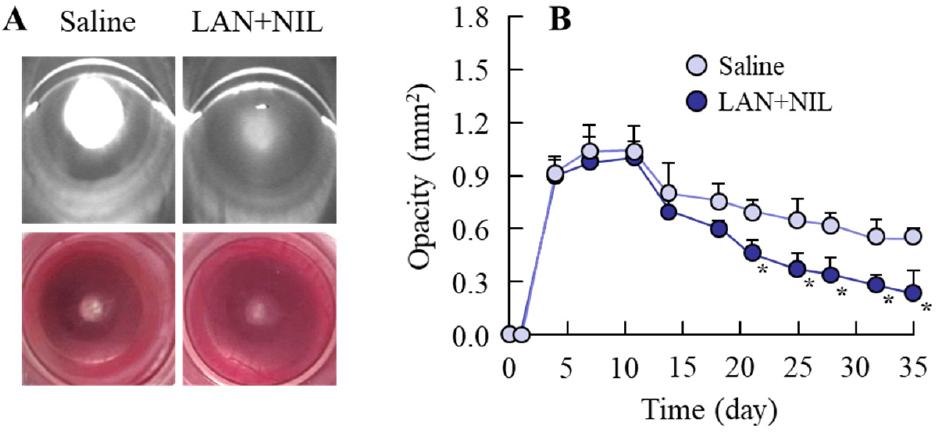
Figure 5. Effect of the combination of LAN-ONSs and NIL-ONSs on opacification in sodium-selenite- induced cataractic rats. ( A ): digital and Scheimpflug slit images of the sodium-selenite-induced cataractic rats repeatedly co-instilled with LAN-ONSs and NIL-ONSs. The images were measured at 35 days after the injection of sodium selenite. ( B ): change in opacity levels in the sodium-selenite- induced cataractic rats repeatedly co-instilled with LAN-ONSs and NIL-ONSs. Twenty microliters of ophthalmic formulations (0.5% LAN or 0.6% NIL), shown in Table 1, were instilled one time/day for 28 days. The start day and the end day of dosing were 7 and 35 days after injection of sodium selenite, respectively. Saline, sodium-selenite-induced cataractic rat repeatedly instilled with saline. LAN + NIL, sodium-selenite-induced cataractic rats repeatedly co-instilled with LAN-ONSs and NIL-ONSs ( n = 7–12). The combination of LAN-ONSs and NIL-ONSs rescued the opacity levels in the sodium-selenite-induced cataractic rats. * p < 0.05 vs. saline for each